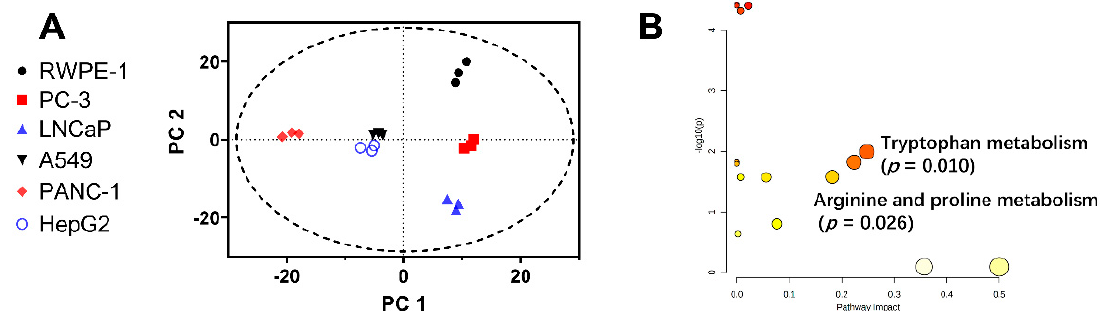
Figure 2. Alteration of tryptophan metabolism pathway between PCa and normal prostate cell lines. ( A ) PCA analysis of UPLC–HRMS metabolic profiles of PC-3, LNCaP, RWPE-1, A459, HepG2, and PANC-1 cells. ( B ) Pathway analysis revealed that tryptophan metabolism was significantly altered between PCa cells (PC-3 and LNCaP) and RWPE-1 cells. Table 1. Cytotoxicities of studied endogenous metabolites in six cell lines.